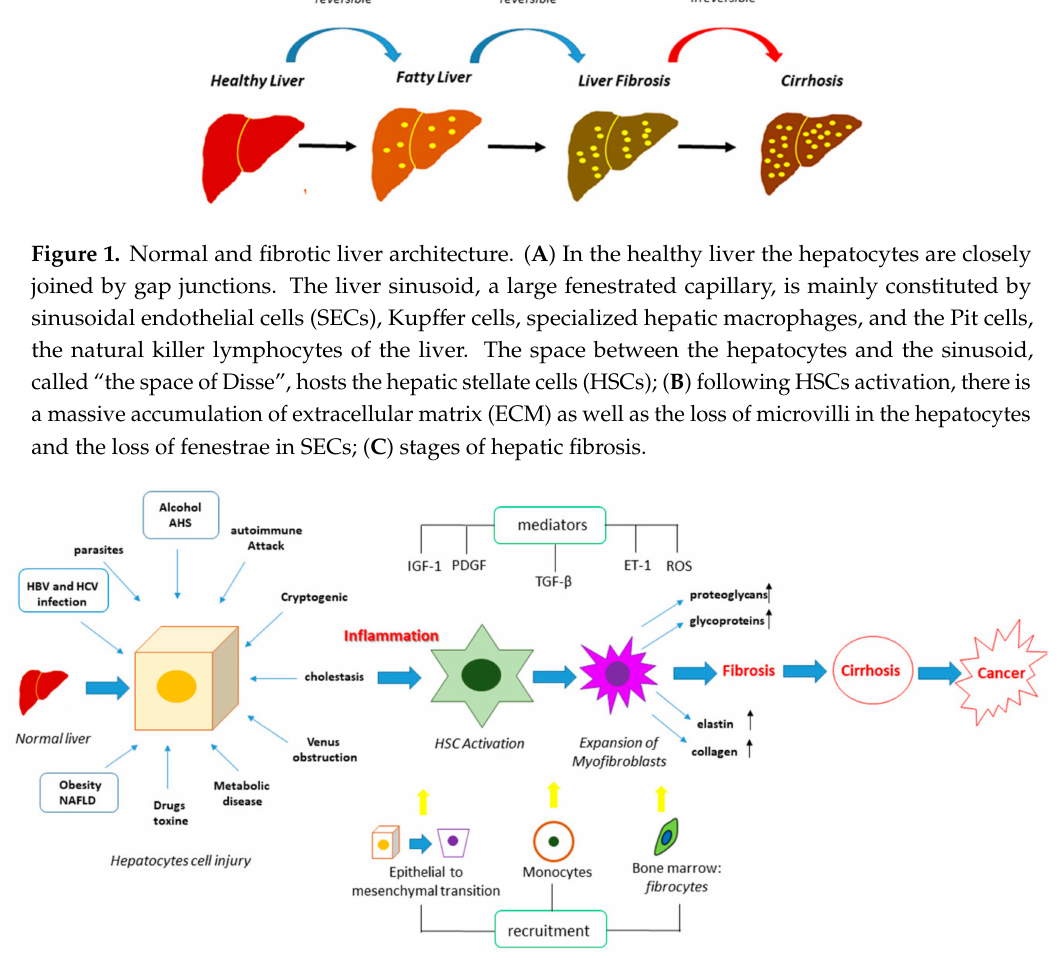
Figure 2. Pathogenesis of liver fibrosis. Liver fibrosis can be induced by di ff erent insults, which can trigger cell death processes in the hepatocytes, leading to the release of pro-fibrogenic mediators such as the transforming growth factor beta (TGF- β ), the platelet-derived growth factor (PDGF), insulin-like growth factor-1 (IGF-1), endothelin 1 (ET-1), and reactive oxygen species (ROS). These can activate HSCs, promoting their di ff erentiation into myofibroblasts, as well as they can stimulate the epithelial to mesenchymal transition and the recruitment of circulating monocytes and fibrocytes from bone marrow. The combination of these events leads to an increased expression and secretion of elastin, collagen, proteoglycans and glycoproteins, causing the accumulation of the ECM and therefore the fibrotic process. This represents a prerequisite for cirrhosis and